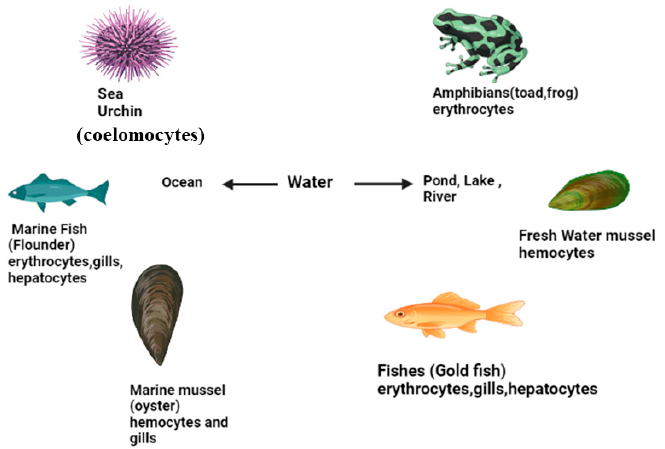
Figure 2. Target cells for comet assay in aquatic organisms.